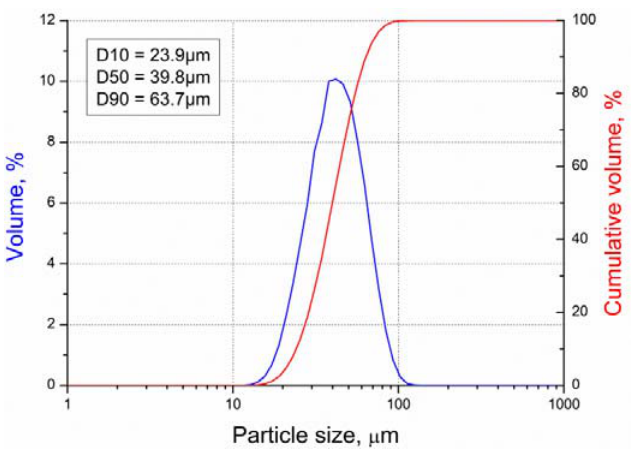
Figure 1. Particle size distributions of 18Ni ‐ M300 powder.